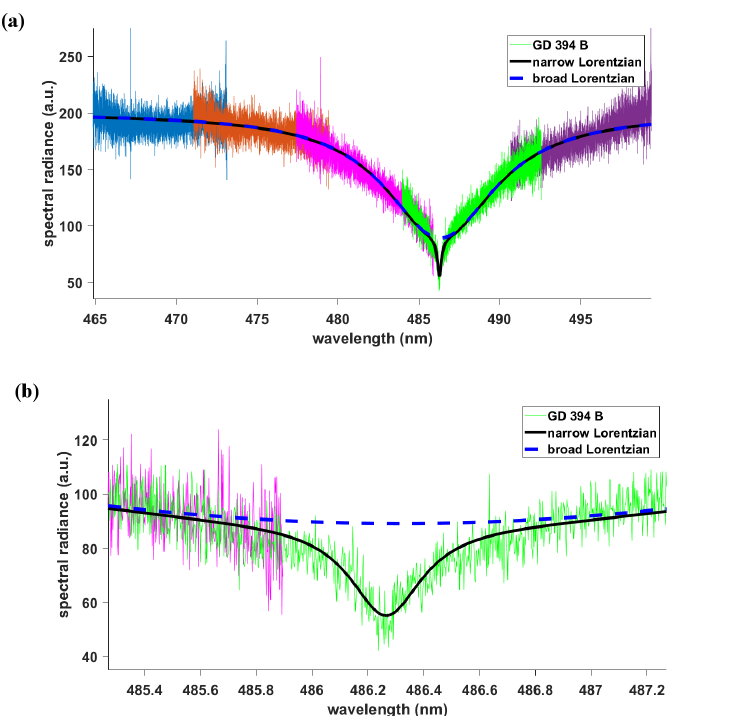
Figure 14. White dwarf GD 394 B, H β combined absorption profiles, recorded with the HIRES echelle spectrometer, KOA-ID: HI.20151115.19364 [3]: ( a ) fitting with two Lorentzians; and ( b ) expanded region.